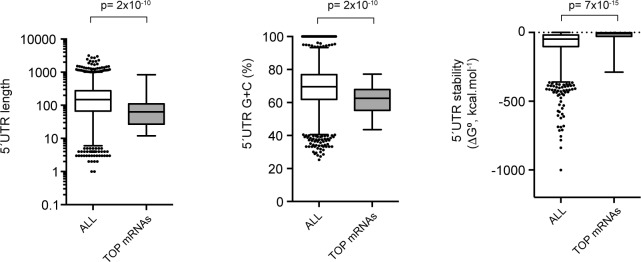
Comparative analysis of the 5′ UTR of TOP mRNAs detected in our dataset.Of the list of 86 validated mRNAs with 5′ TOP elements, only 36 were detected in our dataset. 5′ UTR length and secondary structure content were compared with those of all mRNAs detected in our dataset. The p-values after U test are shown.